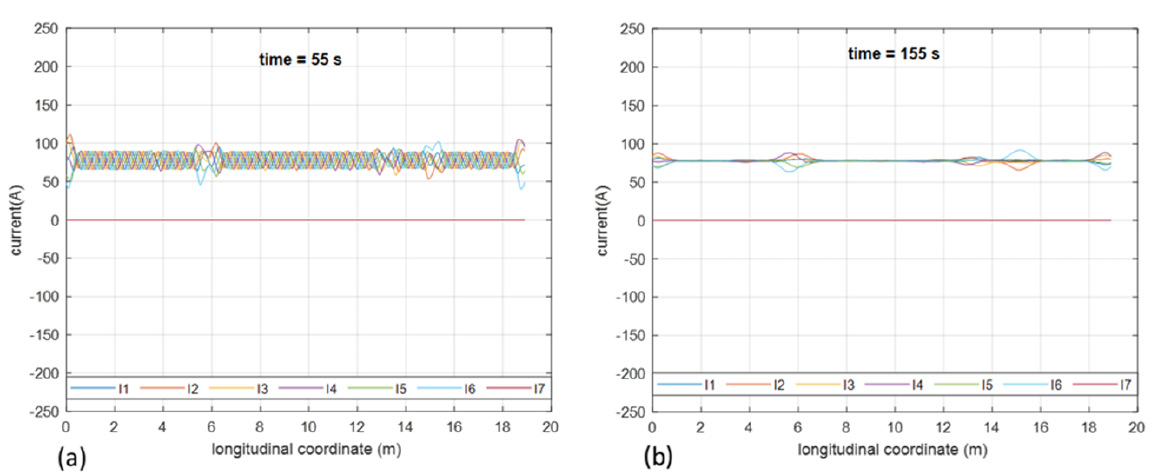
Figure 9. Current of the filaments in ten turns during steady state after ramping cycle at ( a ) t = 55 s and at ( b ) t = 155 s. Currents denoted from I 1 to I 6 are the currents of the superconductor filaments. Current I 7 is the current of the copper